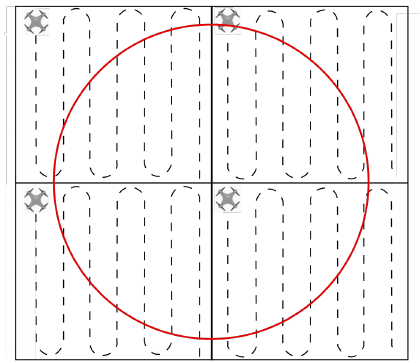
Figure 5. Area decomposed into four subareas by using the back-and-forth